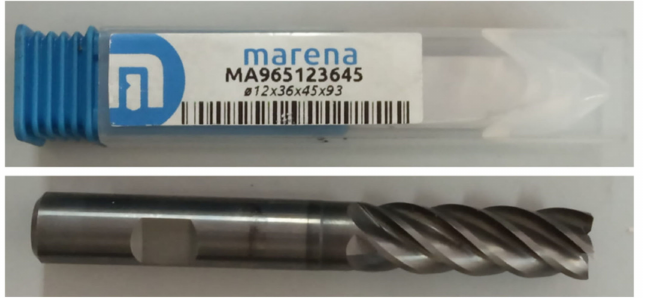
Figure 24. Milling tool used in the experiments. Figure 25 shows the path in the NC display (FAGOR 8060 TM ).